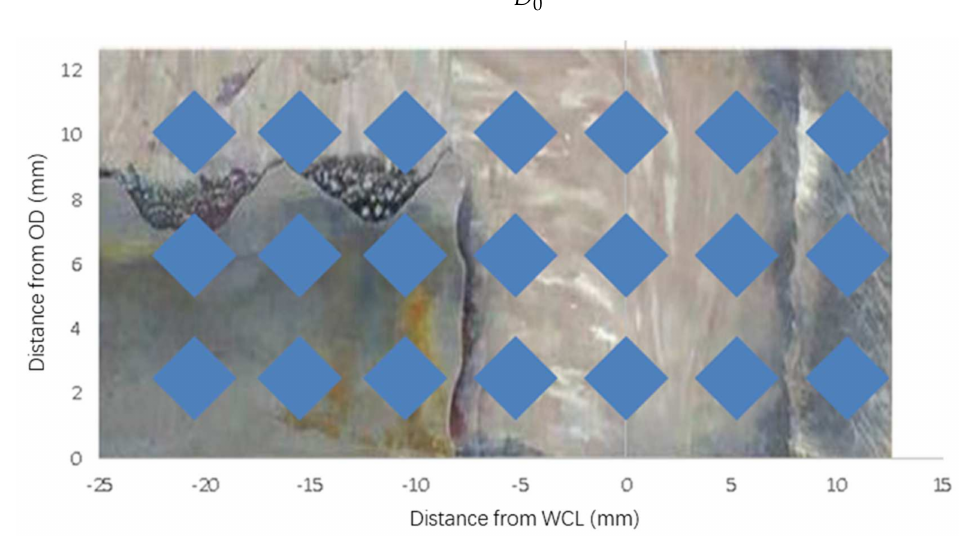
Figure 4. Mapping of the neutron measurement points (blue diamond squares) in the targeted weld area (gauge volume = 3 mm × 3 mm × 3